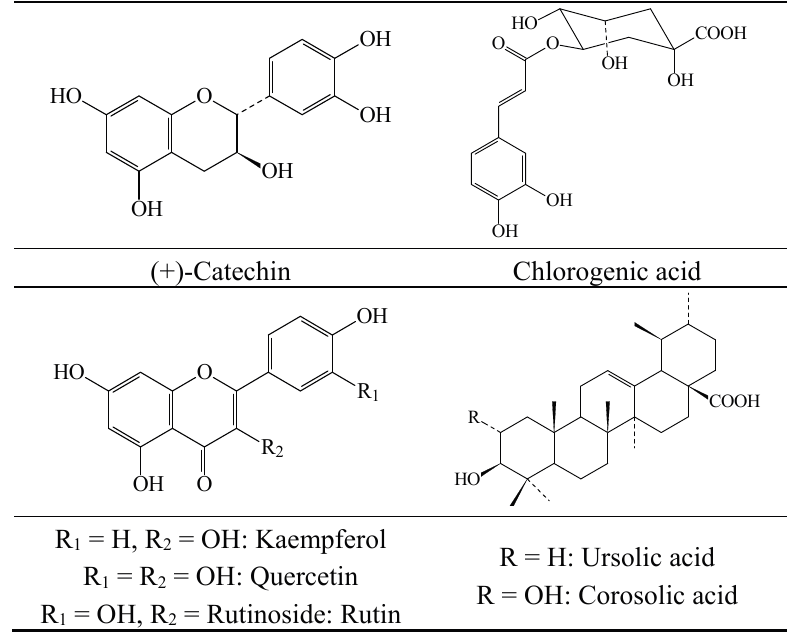
Figure 4. Structures of the compounds identified in the leaves and fruits of C. gracilior